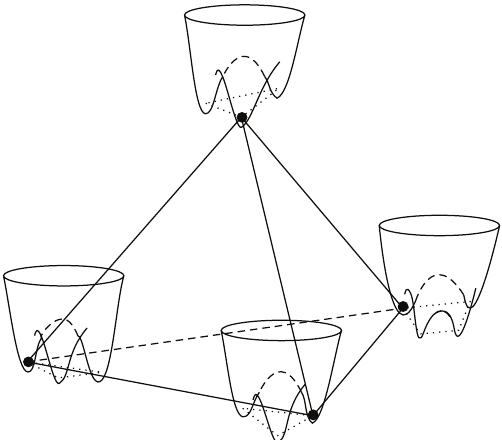
Figure 15: A cluster of 𝑁 = 4 weakly interacting (real) tunneling particles that is being replaced with a (fictitious) single 3LS (Fig- ure 4(c)) having renormalised parameters according to (A.9) and (A.10). ⟨𝐿𝑅𝑅|𝐻 |𝑅𝐿𝐿⟩ and ⟨𝑅𝐿𝐿|𝐻 |𝐿𝑅𝑅⟩ , which are all 3 3